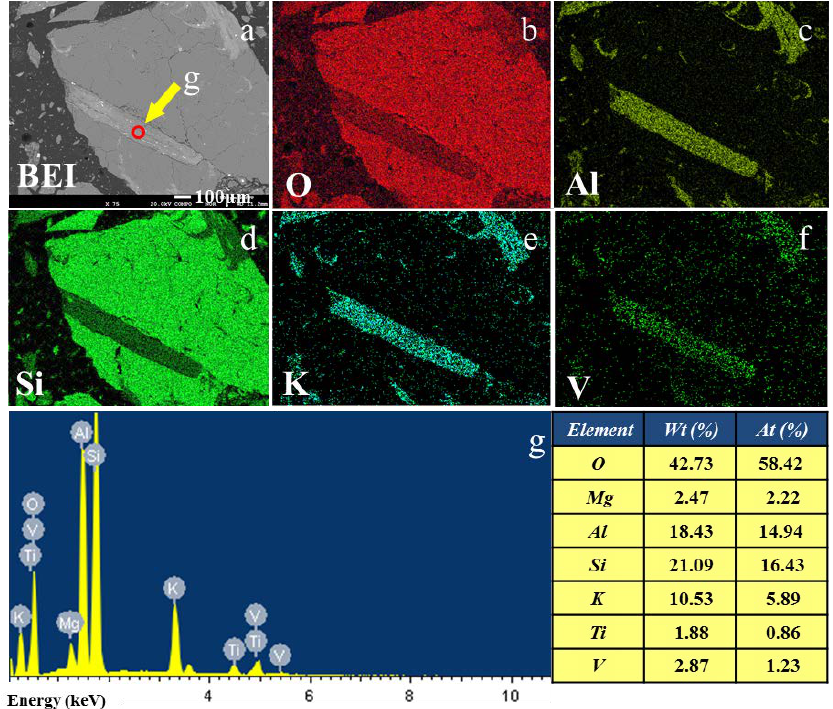
Figure 1. ( a ) BEI of decarbonized stone coal, EDS elemental distribution: ( b ) O; ( c ) Al; ( d ) Si; ( e ) K; ( f ) V, and ( g ) EDS spectra collected from BEI as marked by